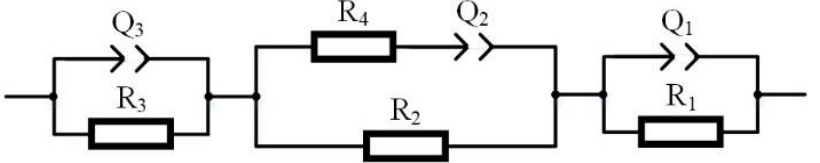
Figure 2. Equivalent circuit model for impedance analysis of porous materials, such as soils. The three circuit parts Q 3 // R 3 , (R 4 + Q 2 ) // R 2 and Q 1 // R 1 model the resistive effects inside soil grains, related to the soil pore network and at the soil–electrode interface, respectively.